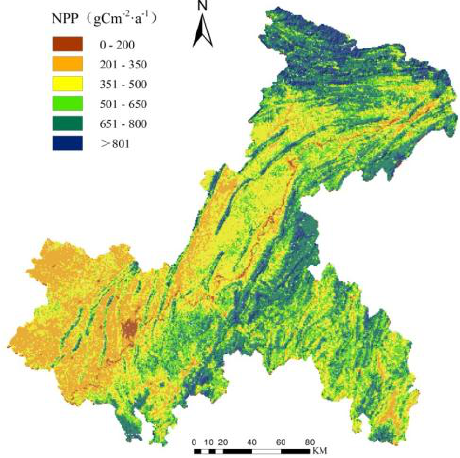
Figure 3. Spatial distribution of mean NPP from the year 2001 to 2011.